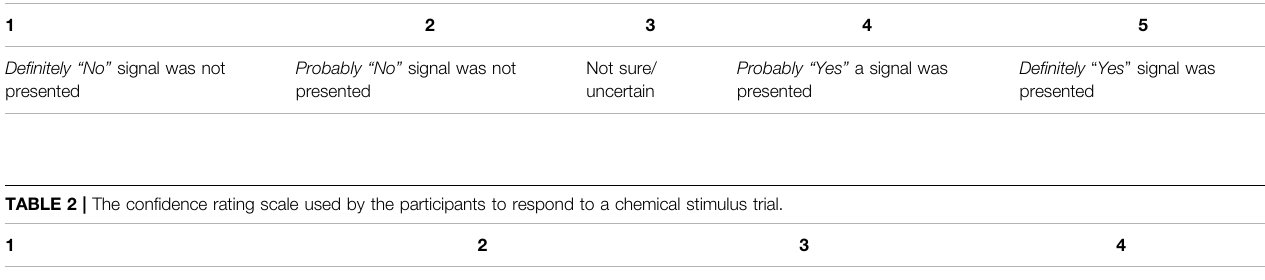
TABLE 1 | The con fi dence rating scale used by the participants to respond to a mechanical or a cold stimulus trial.